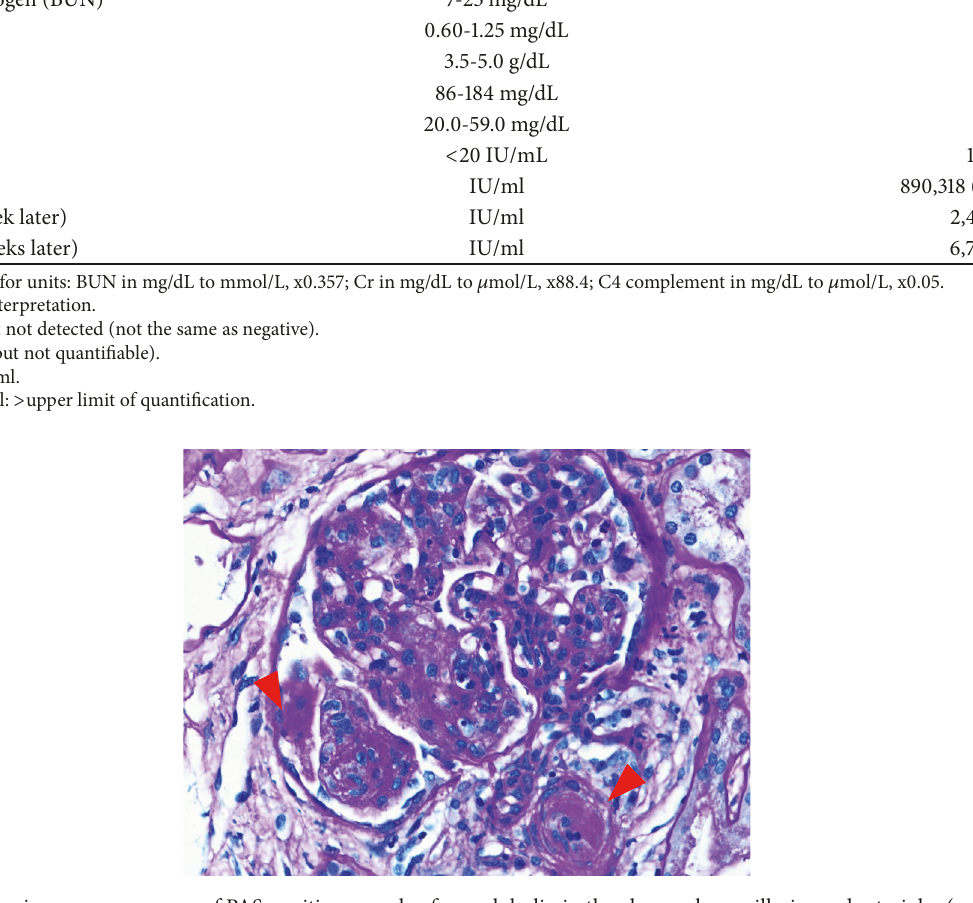
Figure 1: Light microscopy: presence of PAS-positive coagula of cryoglobulin in the glomerular capillaries and arterioles